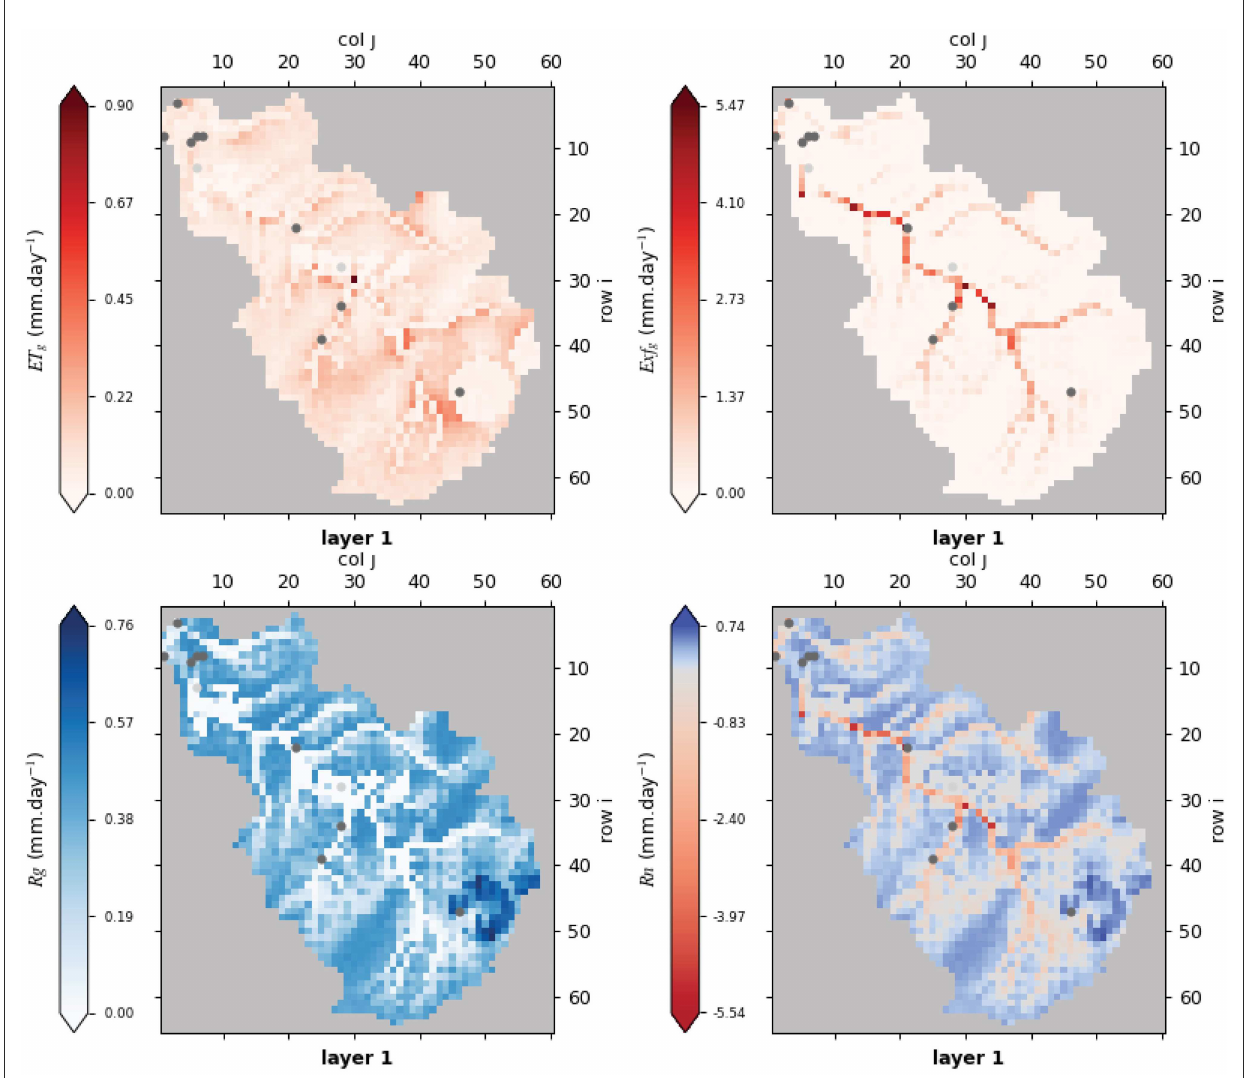
observations points of Figure